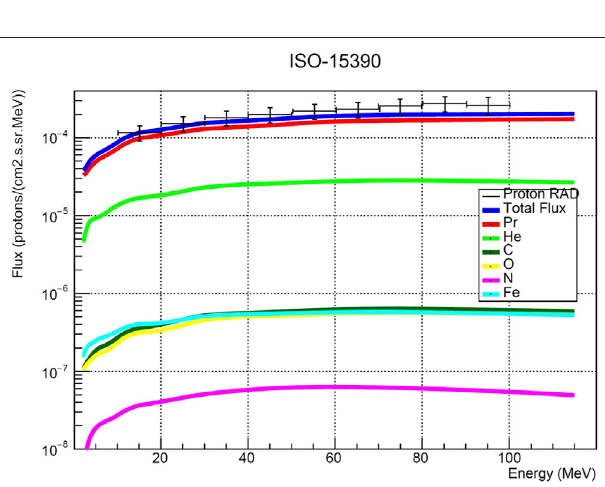
FIGURE 7 | Differential proton fl ux spectra obtained with dMEREM compared to GCR-induced proton spectrum measured by RAD in 15 November 2015 – 15 January 2016 (Ehresmann et al., 2017). Proton fl uxes induced by primary H, He, C, N, O, and Fe nuclei are based on ISO- 15390